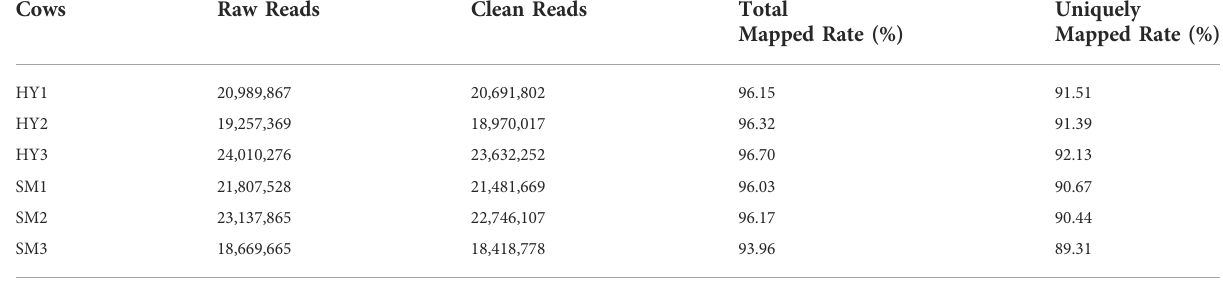
TABLE 1 Summary of reads mapped to the bovine genome. Cows Raw Reads Clean Reads Total